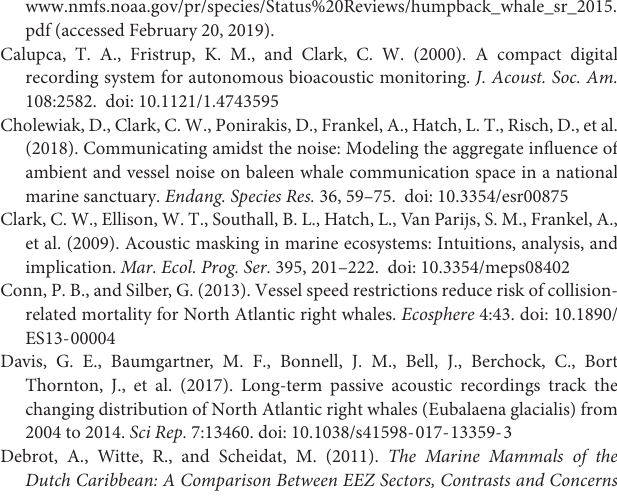
FIGURE S1 | Detailed maps of the recording sites located near each island, with symbols indicating the type of recorder deployed at each site [Marine Acoustic Recording Unit (MARU), SoundTrap, or both], as well as the locations of all major ports. FIGURE S2 | The acoustic signature of an earthquake detected at 01:23 UTC-4 on 17 April, 2017 off the Antigua Islands. The MARU at Guadeloupe East was closest to the epicenter of the quake at 130 km while the St. Martin SoundTrap was approximately 209 km from the epicenter. The MARU at Aruba was the furthest from the epicenter at 1091